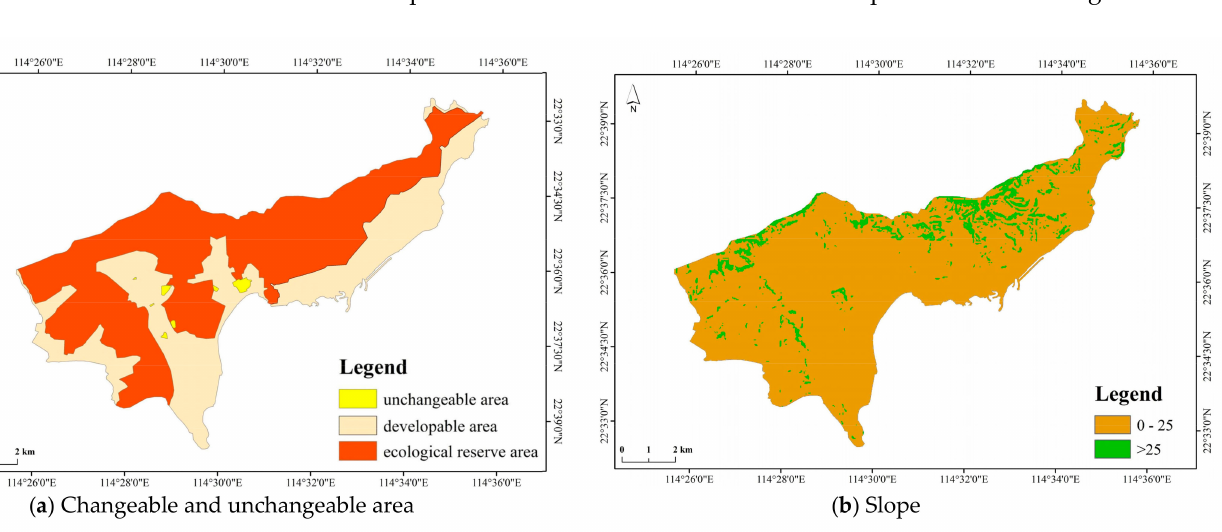
The unchangeable area is shown in Figure 7a, including reserved villages (e.g., Dapeng Ancient City) and ecological preservation regions. Figure 7b shows a slope-constraint map that identifies potential construction lands where the slope is less than 25 degrees.